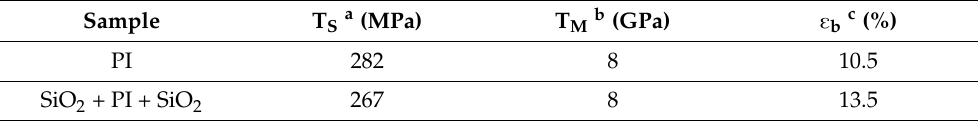
Table 4. Mechanical properties of PI membranes before and after coated with SiO 2 antireflective membrane.